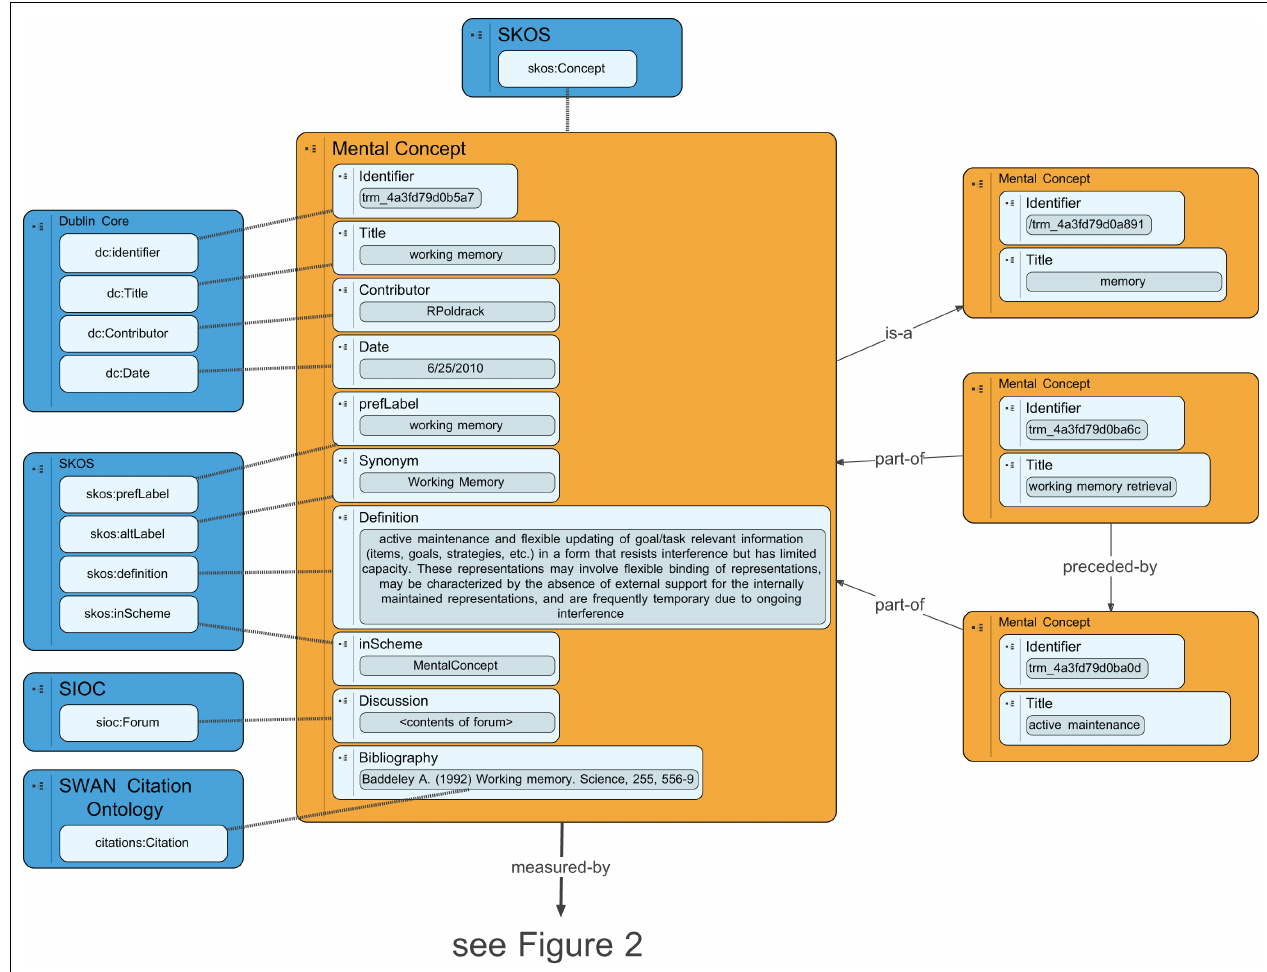
FIGURE 1 |An overview of the database schema for representation of mental concepts in the CognitiveAtlas. Blue boxes reflect external ontologies, and dashed lines reflect class inheritance, while solid lines reflect ontological